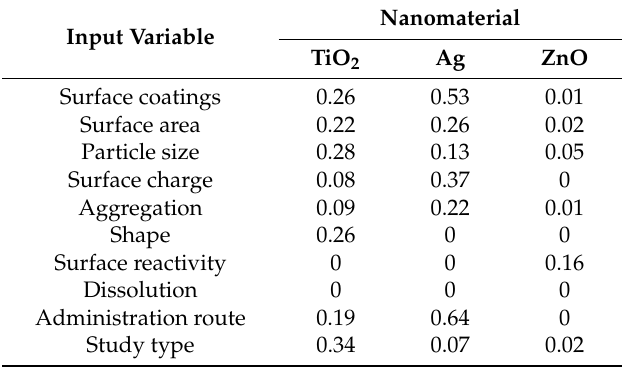
Table 4. Effect of particle size on the normalised NM hazard potential for TiO 2 , Ag, and ZnO.